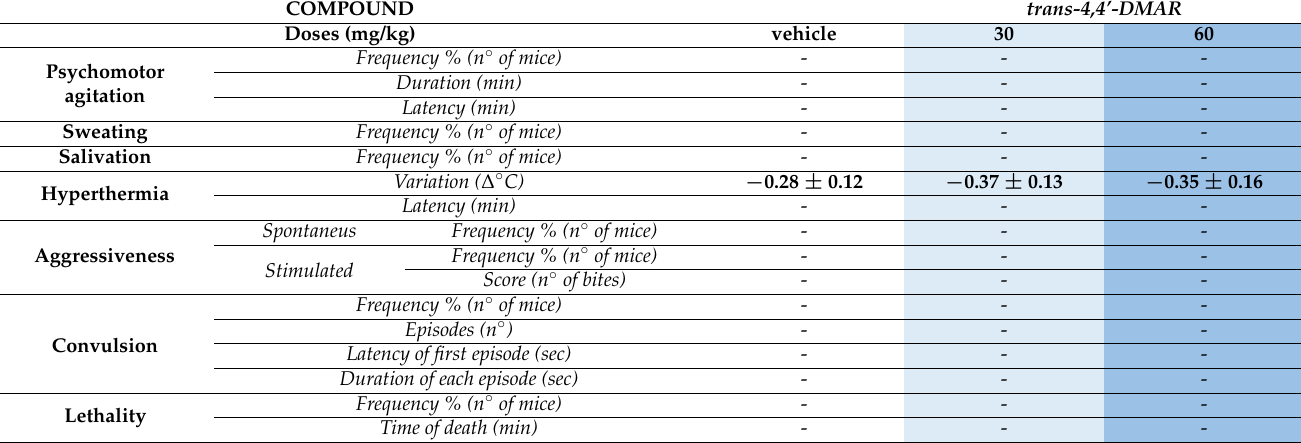
Table 2. Effect of ( ± ) trans -4,4 (cid:48) -DMAR (30 and 60 mg/kg i.p.) on neuro-behavioural changes (psychomotor agitation, aggressiveness, convulsion), physiological alterations (sweating, salivation, hyperthermia) and lethality in mice. Data expressed (see material and methods) represents the mean ± SEM of six animals for each treatment. The statistical analysis of the effects of the ( ± ) trans -4,4 (cid:48) -DMAR in different concentrations were performed using a one-way ANOVA followed by a Bonferroni test for multiple comparisons. A Student’s t -test was used to determine statistical significance ( p < 0.05) between the two groups.